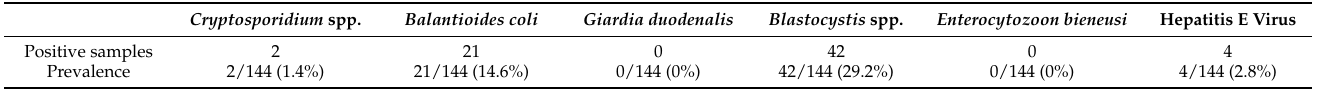
Table 1. Summary of prevalences of microeukaryote parasites and HEV in wild boar of Portugal. Cryptosporidium